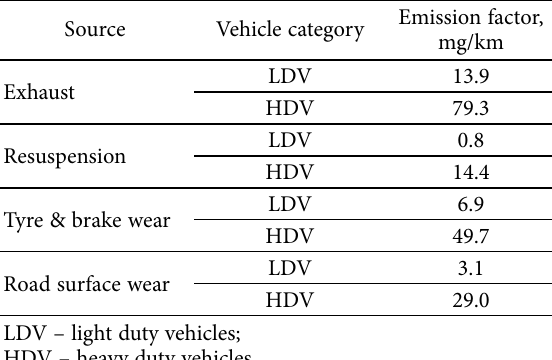
Table 1. Emission factors for PM 10 particles